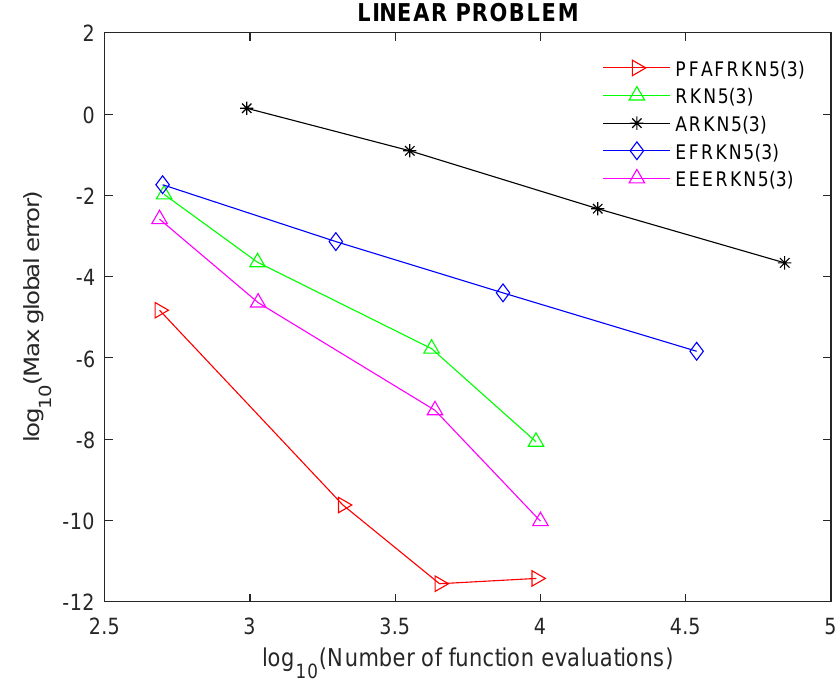
Figure 5. Efficiency curves corresponding to Problem 5. The new pair PFAFRKN5(3) gives minimum error norm, minimum number of function evaluations and minimum computational cost. Tables 2–6 and Figures 1–5 present evidence that PFAFRKN5(3) is a very efficient scheme. Therefore, we can say that PFAFRKN5(3) is more appropriate for solving the type of problems in (1) than other existing embedded 5(3) pairs of RKN methods with four stages in the